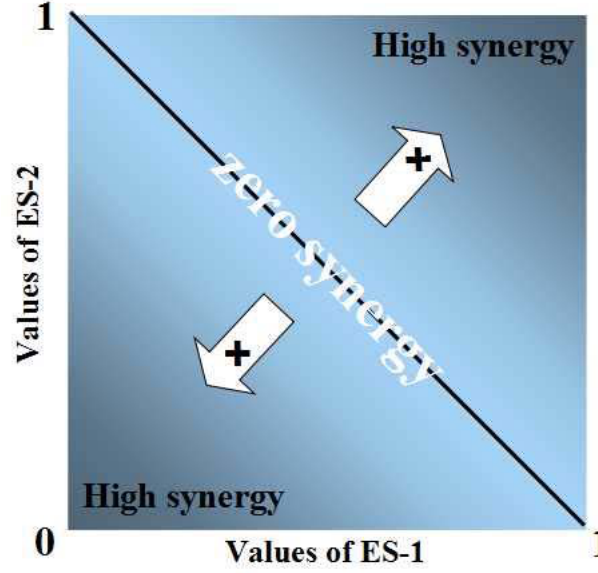
Figure 2. Illustration of overall synergy between two ecosystem services. Illustration of overall synergy between two ecosystem services. The overall Synergy is calculated as the RMSE of the individual benefits and increases with the distances from the reverse 1:1 line.